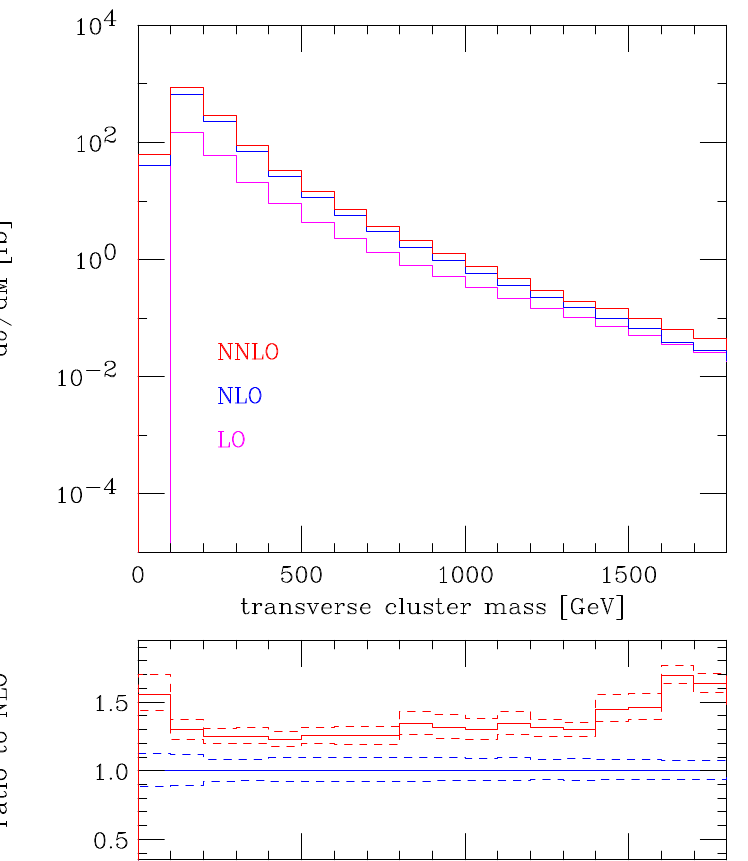
Figure 10 . Cluster transverse mass of the ( ‘ – γ – ν ) system, defined in eq. (6.2), at 13 TeV. The lower panel displays the ratio of the NLO and NNLO predictions, including error estimates obtained via a 9-point scale variation, to the central NLO result.